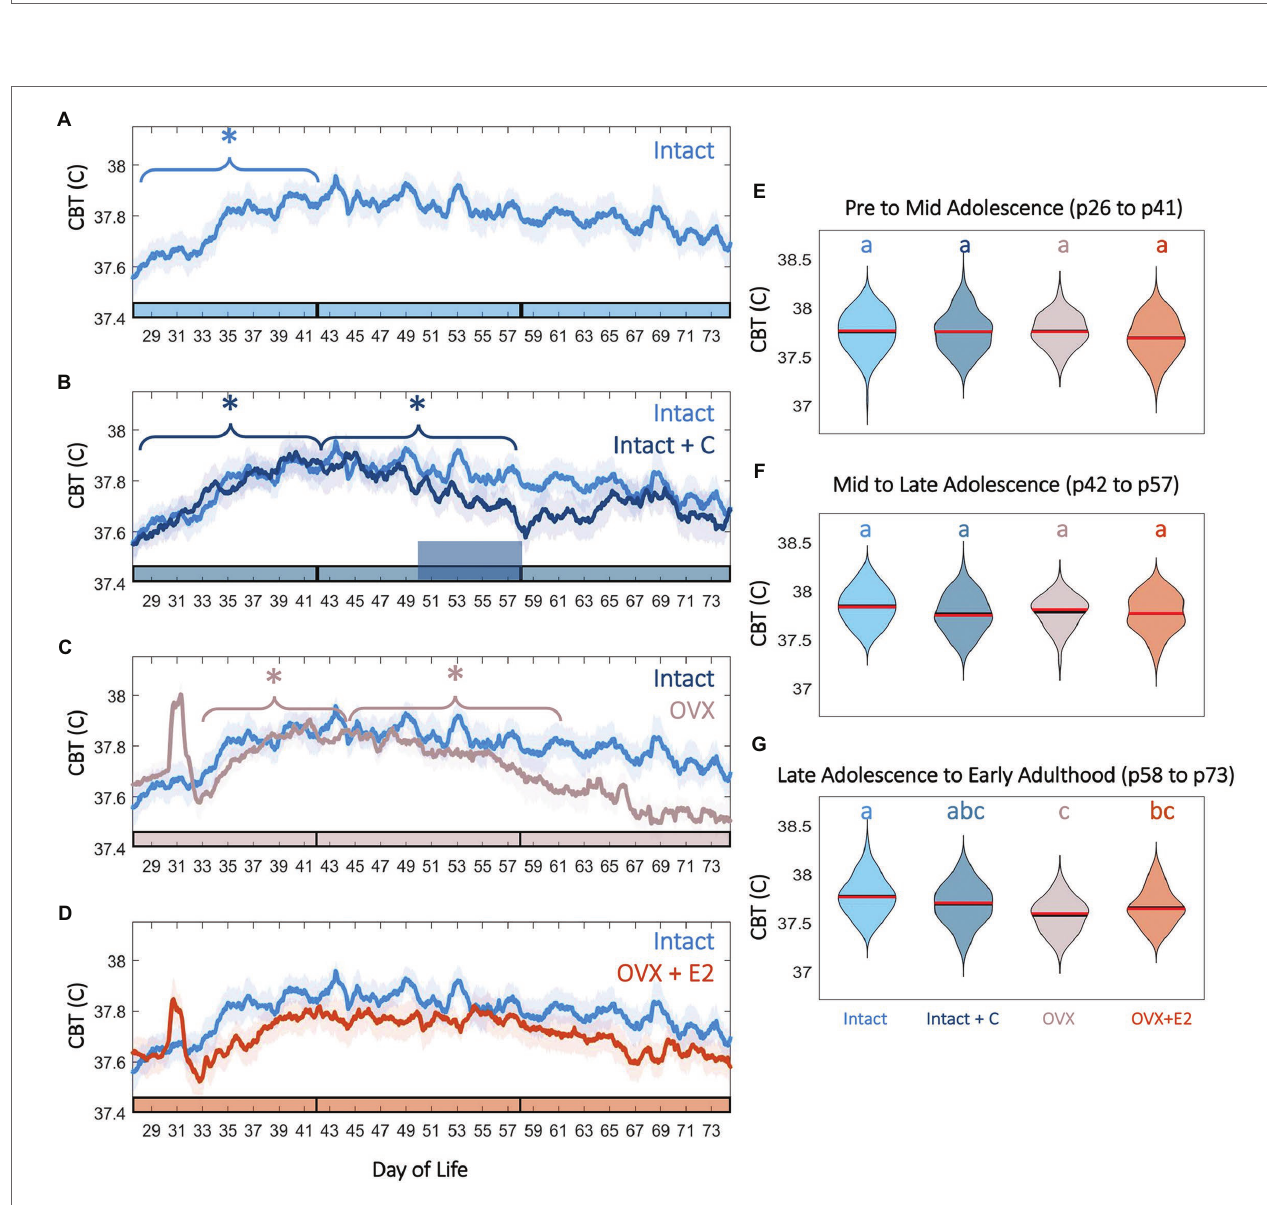
FIGURE 3 | along the x-axis for Intact + C animals indicate average time of contraceptive administration relative to fE2 rise. * indicates regions of time over which every 4th day’s CBT values are significantly elevated compared to other days of cycle ( p < 0.003). Twenty-four hour smoothed average plots of normalized linear CBT in Intact (C) and Intact + C (D) individuals from the time of contraceptive administration illustrate a reduction in regularity of 4-day oscillations. Insets show FFT centered at 4–5 days. * indicates significantly higher AUCs in the 4–5 day range for Intact (panel C ) compared to Intact + C rats (panel D ). Individual animals (E–T) comprising Intact (light blue) and Intact + C (dark blue) groups prior to and following hormonal contraceptive administration. Dark bars along horizontal axes indicate time of contraceptive administration; administration days differ based on an individual’s day of fE2 rise.